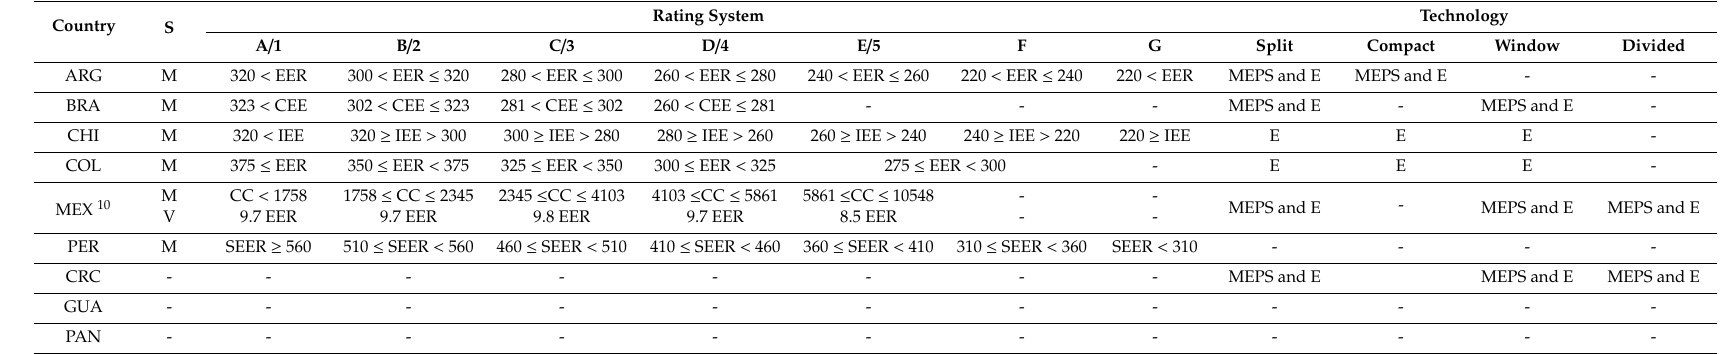
Table 5. Comparison of air-conditioning standards in the region. We show the air conditioning (AC) rating systems of the reviewed countries. Some use labels in (A, G) whereas others within (1,5). Both are shown. EER stands for energy e ffi ciency ratio, SEER stands for seasonal energy e ffi ciency ratio, CEE and CC stand for cooling capacity, and IEE stands for energy e ffi ciency index (Indice de Eficiencia Energ é tica). We also show (right-hand side) the status (S) of whether a minimum energy performance standard (MEPS) and an energy rating system (E) exist in each country. “-” stands for “no standard”. Country S Rating